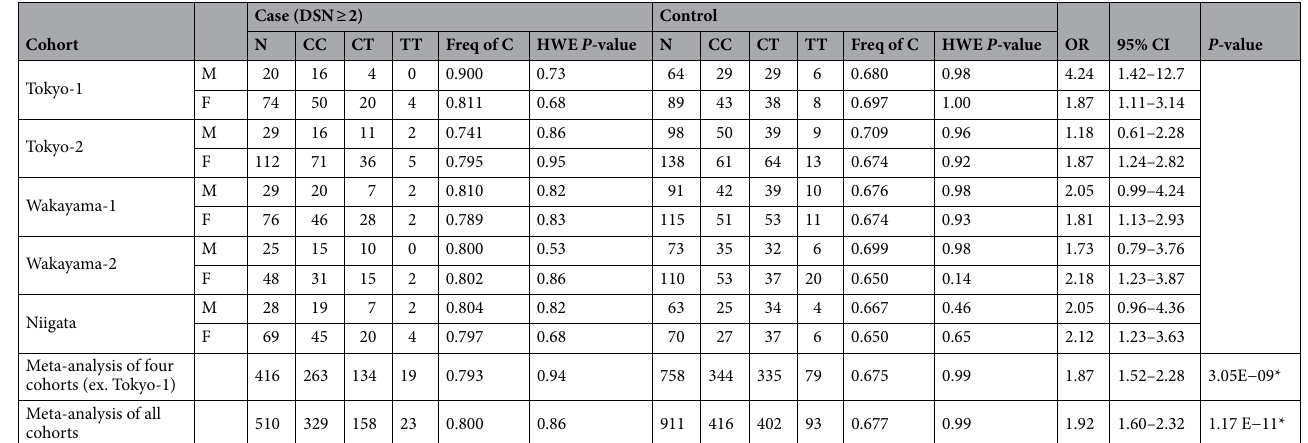
Table 2. Genotyping of rs2054564 in each cohort. M male, F female, N number; Freq frequency, HWE Hardy–Weinberg equilibrium, OR odds ratio, CI confidence interval, DSN disc space narrowing. *Statistically significant with a genome-wide significance threshold of P -value < 5.0 × 10 –8